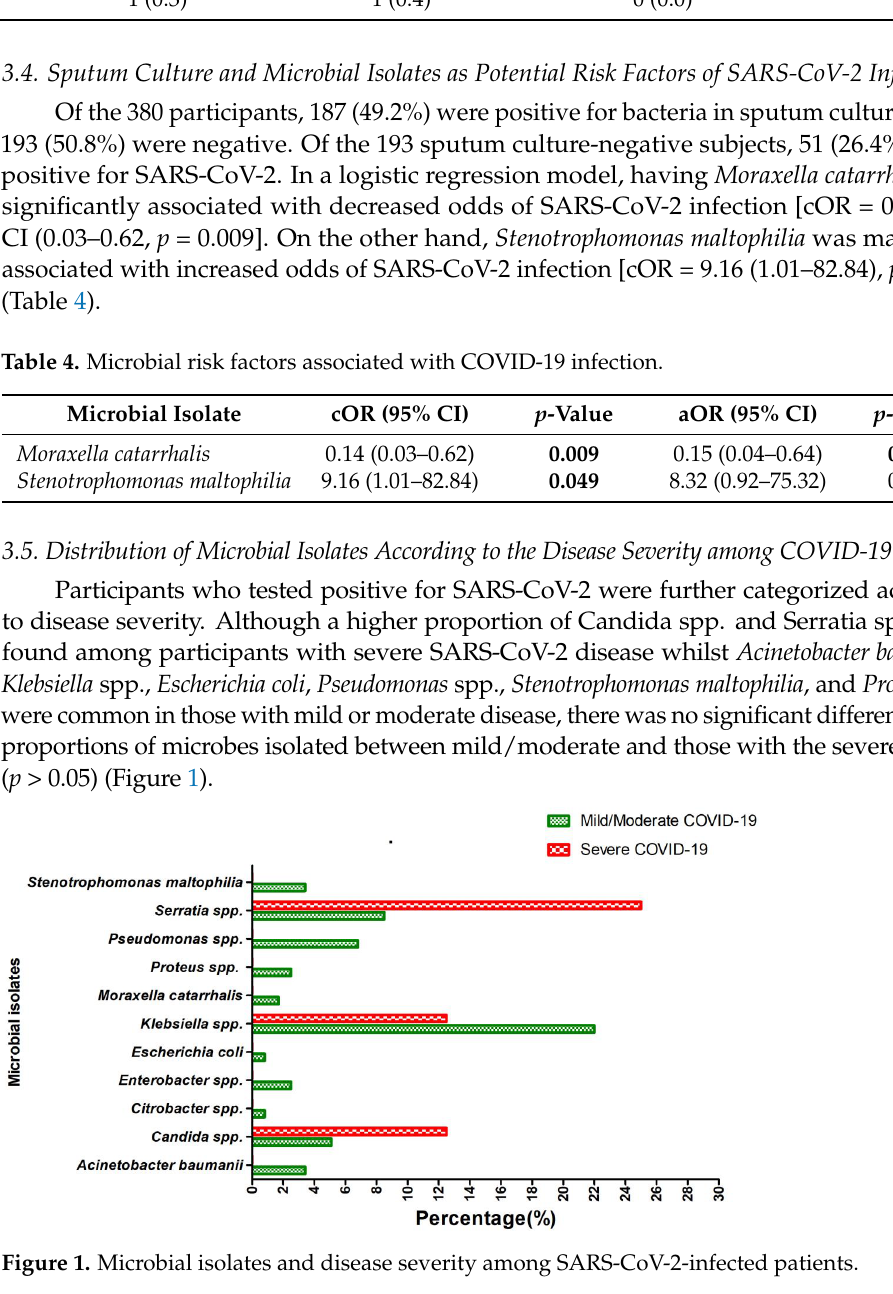
Figure 1. Microbial isolates and disease severity among SARS-CoV-2-infected patients .